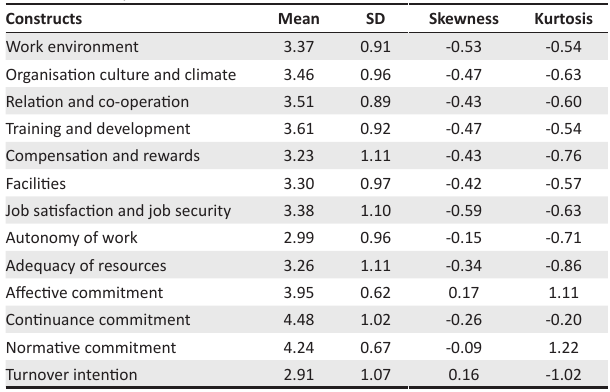
TABLE 1: Descriptive statistics of the